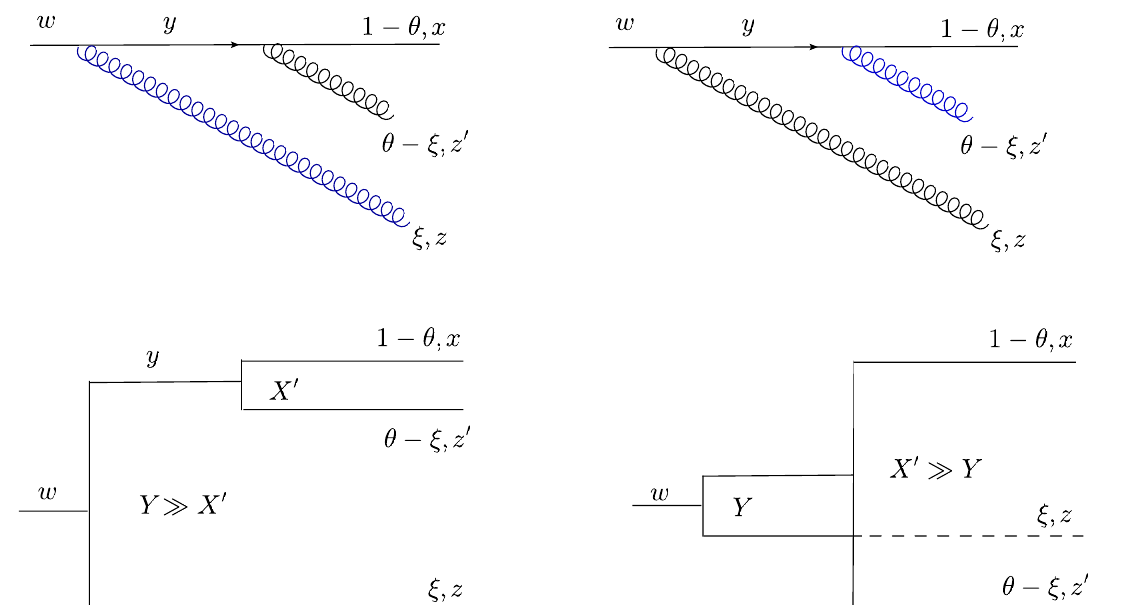
Figure 21 . Graphical illustration of the collinear limits corresponding to the two gluon emissions by the incoming quark. The Feynman graphs in the first line show the topology of the emission: the gluon emerging from a collinear splitting is represented in blue. The schematic diagrams in the second line illustrate the geometry of the splittings in the transvserse coordinate